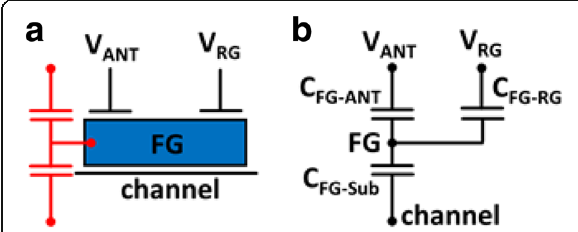
Fig. 7 a The schematic diagram of a capacitance network model in a CSIR device. b The total capacitance of floating gate is all mentioned capacitances in series plus that in parallel